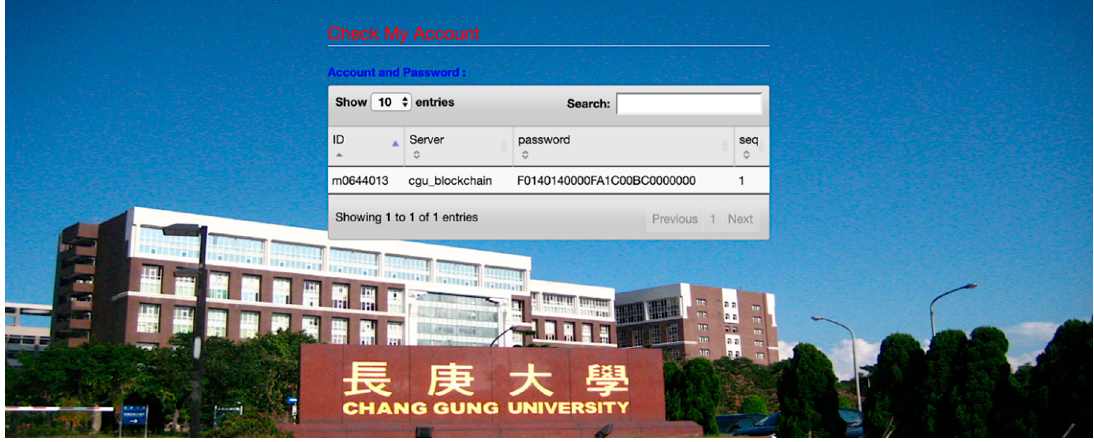
Figure 13. Account generated by SSO server.